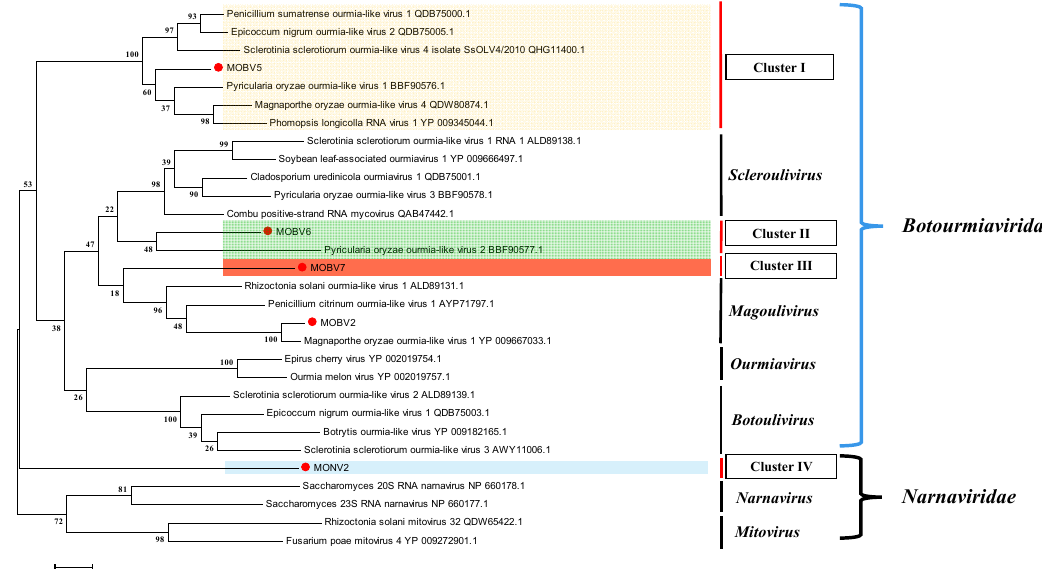
Figure 5. A maximum likelihood phylogenetic tree constructed based on an alignment of the respective RdRp amino acid sequences of MOBV2, MOBV5, MOBV6, MOBV7, and MoNV2 against other members of the families Botourmiaviridae and Narnaviridae . There were four established genera in the family Botourmiaviridae . MOBV2 was grouped into the genus Magoulivirus , while MOBV5, MOBV6, and MOBV7 (indicated with red dots) were grouped into three different clusters with certain unclassified Botourmiaviruses. Bootstrap values (%) obtained with 1000 replicates are indicated on branches. The names and GenBank accession numbers of other viruses are shown.